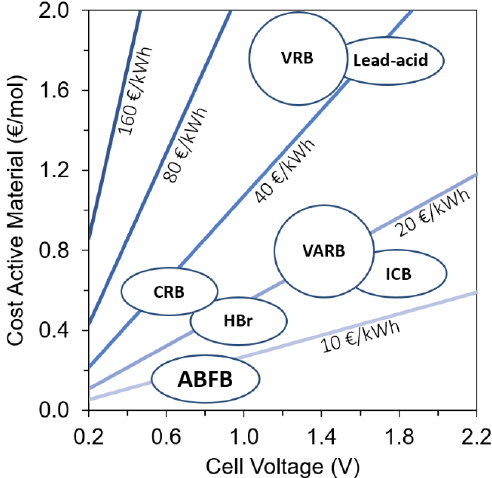
Figure 6. Energy costs (€/kWh) related to the active materials used for storage in the ABFB and various redox flow batteries. CRB, all-copper redox flow battery; HBr, hydrogen bromine redox flow battery; ICB, iron chromium redox flow battery; VARB, vanadium/air redox flow battery; VRB, vanadium redox flow battery.